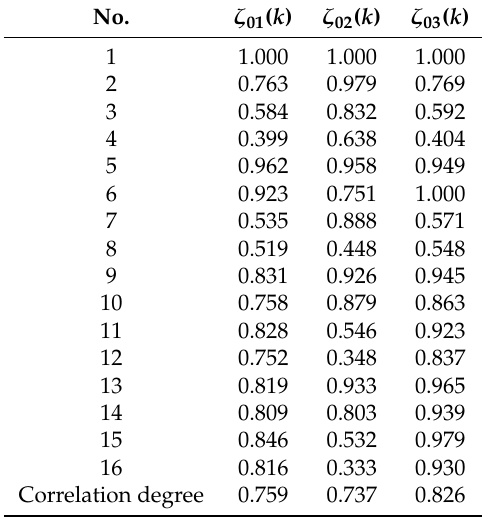
Table 9. Calculation results of correlation degree.